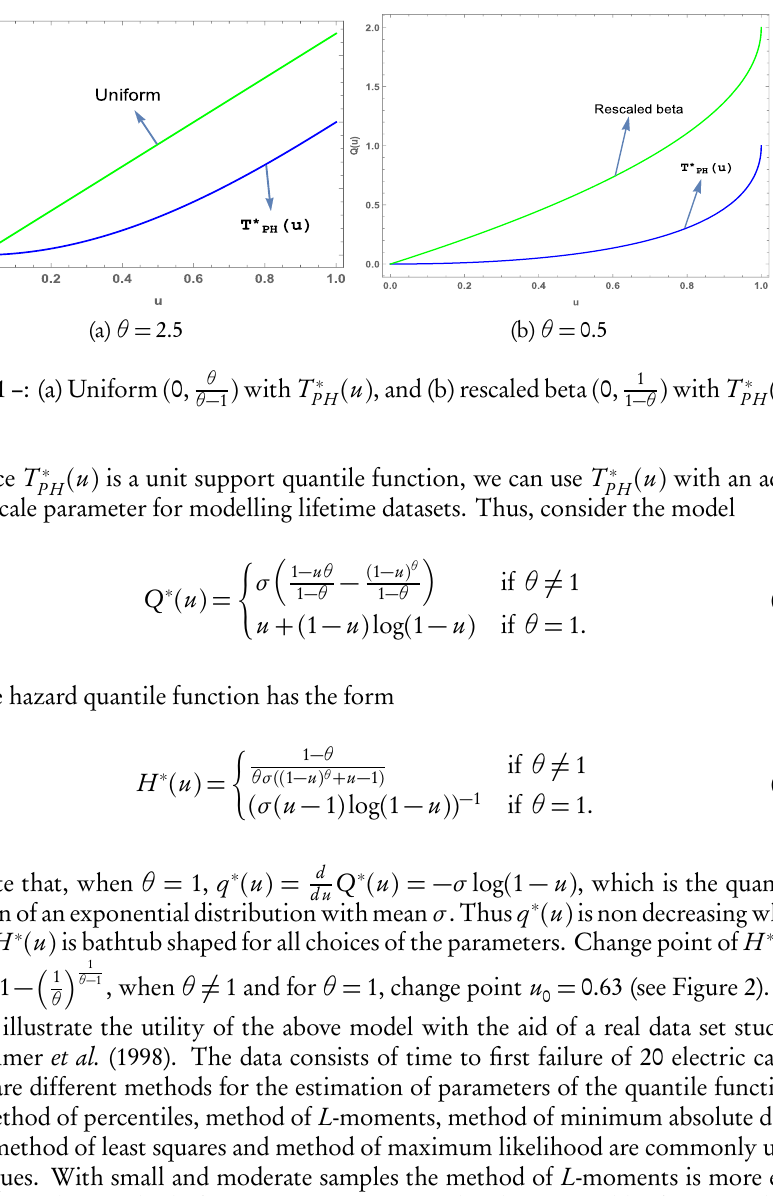
Figure 1 –: (a) Uniform ( 0,